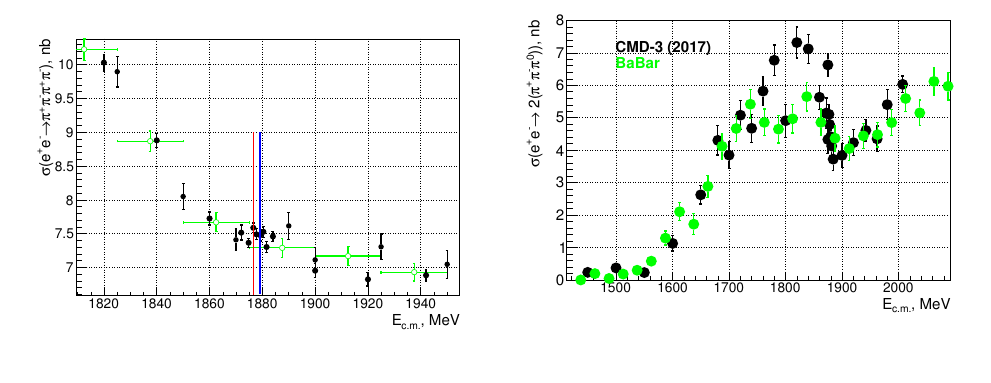
Figure 7. The e + e − → 2( π + π − ) π 0 π 0 cross sec- tion measured with CMD-3 (dots, very prelimi- nary) and BaBar [6] (open